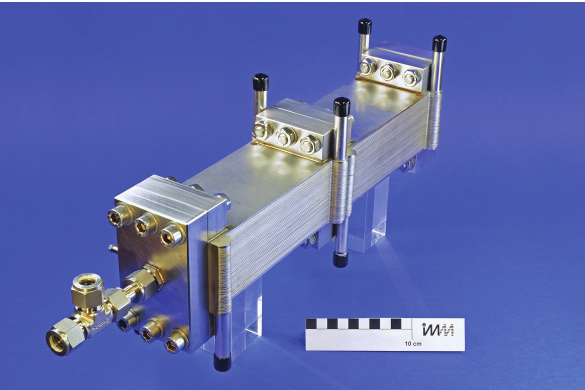
Figure 2 Modular microreactor (vacuum brazed) with integrated heat exchange function and a micromixer connected